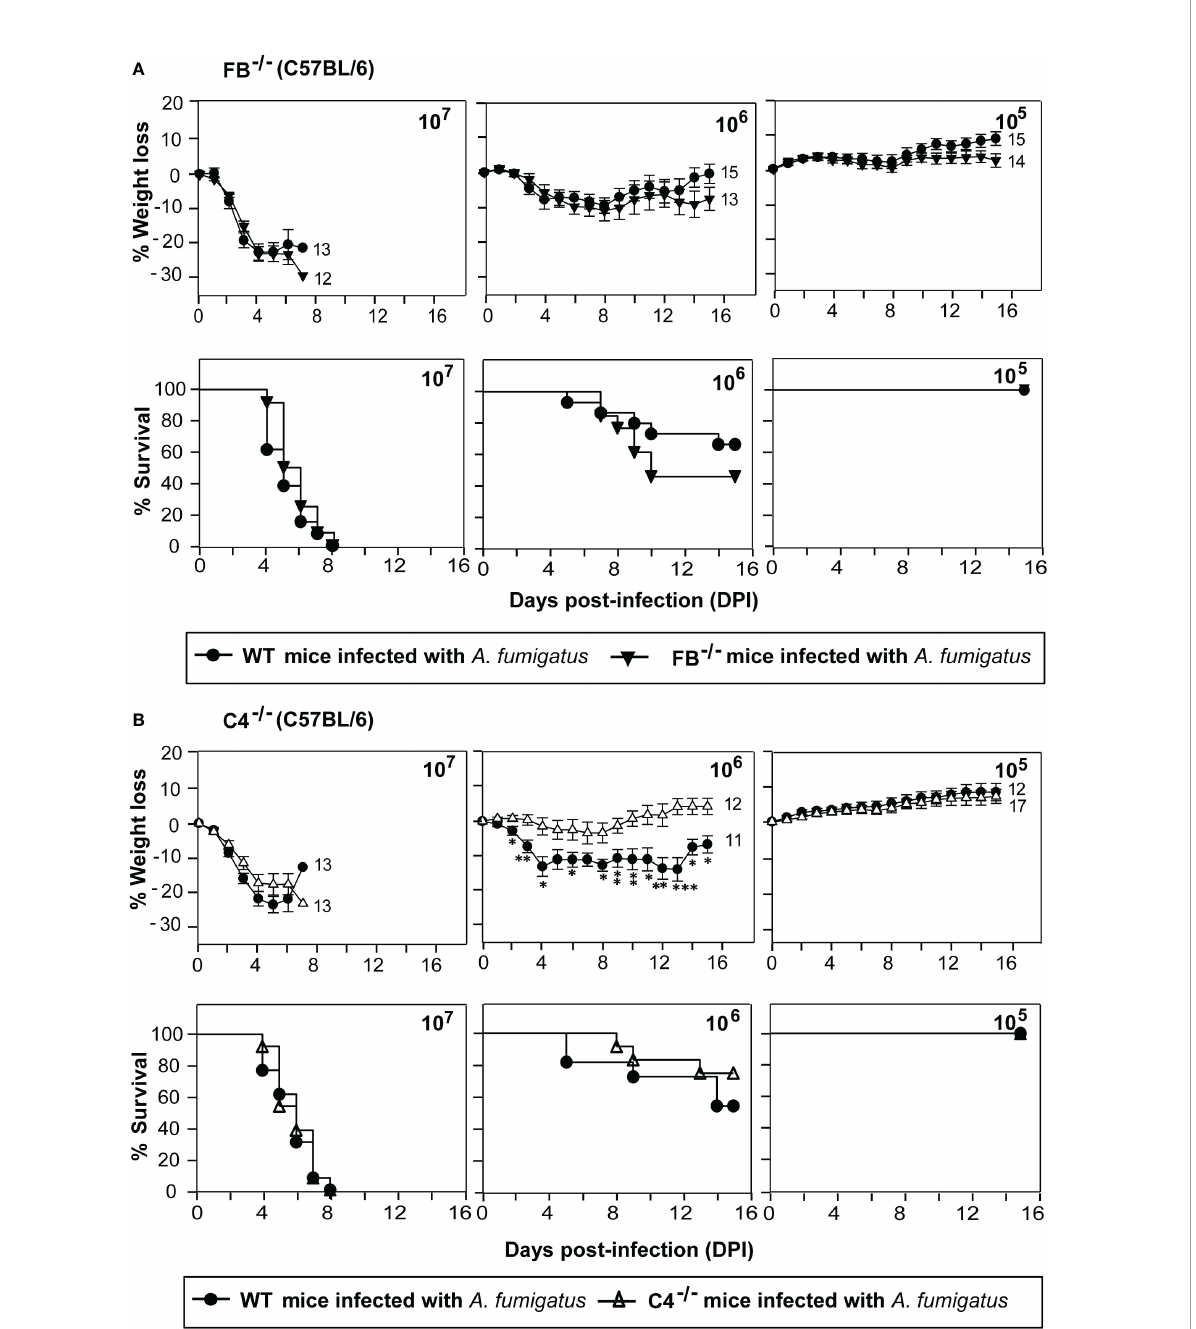
FIGURE 2 Susceptibility of factor B and C4 de fi cient mice to systemic A fumigatus infection. Mice were intravenously infected with indicated amounts of conidia (1x10 5 , 1x10 6 , or 1x10 7 ) and observed for body weight loss and survival. (A) Percentage of body weight loss and survival in complement factor B de fi cient mice (FB -/- ; C57BL/6 background) in comparison to the wild-type mice (WT; C57BL/6 background). There is no difference in the weight loss and survival of FB -/- mice compared to the WT mice. (B) Percentage of body weight loss and survival in complement C4 de fi cient mice (C4 -/- ; C57BL/6 background) in comparison to the wild-type mice (WT; C57BL/6 background). C4 -/- mice did not show more weight loss and reduced survival compared to the WT mice. (% weight loss: ***p < 0.0005; **p < 0.005 *p < 0.05). Results shown are mean ± SEM of three independent